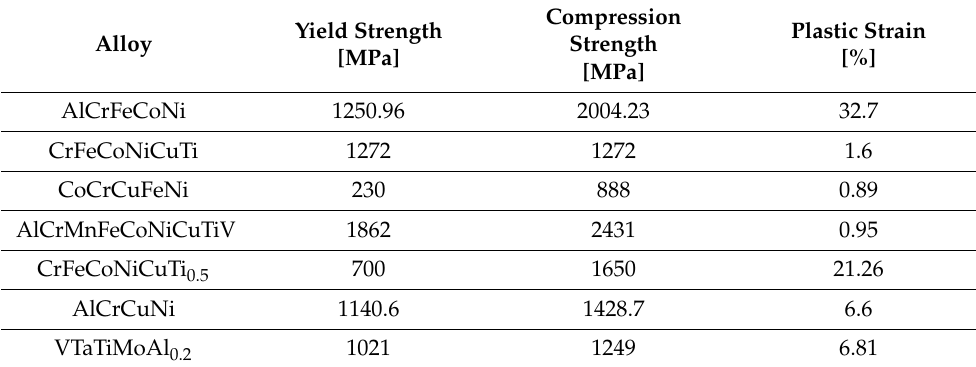
Table 1. Room temperature mechanical properties of selected high-entropy alloys [48–51].